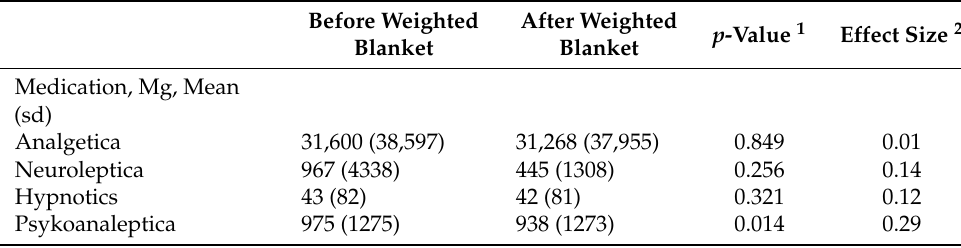
Table 5. Medication, before and after utilisation of weighted blanket for 28 days, n = 68.